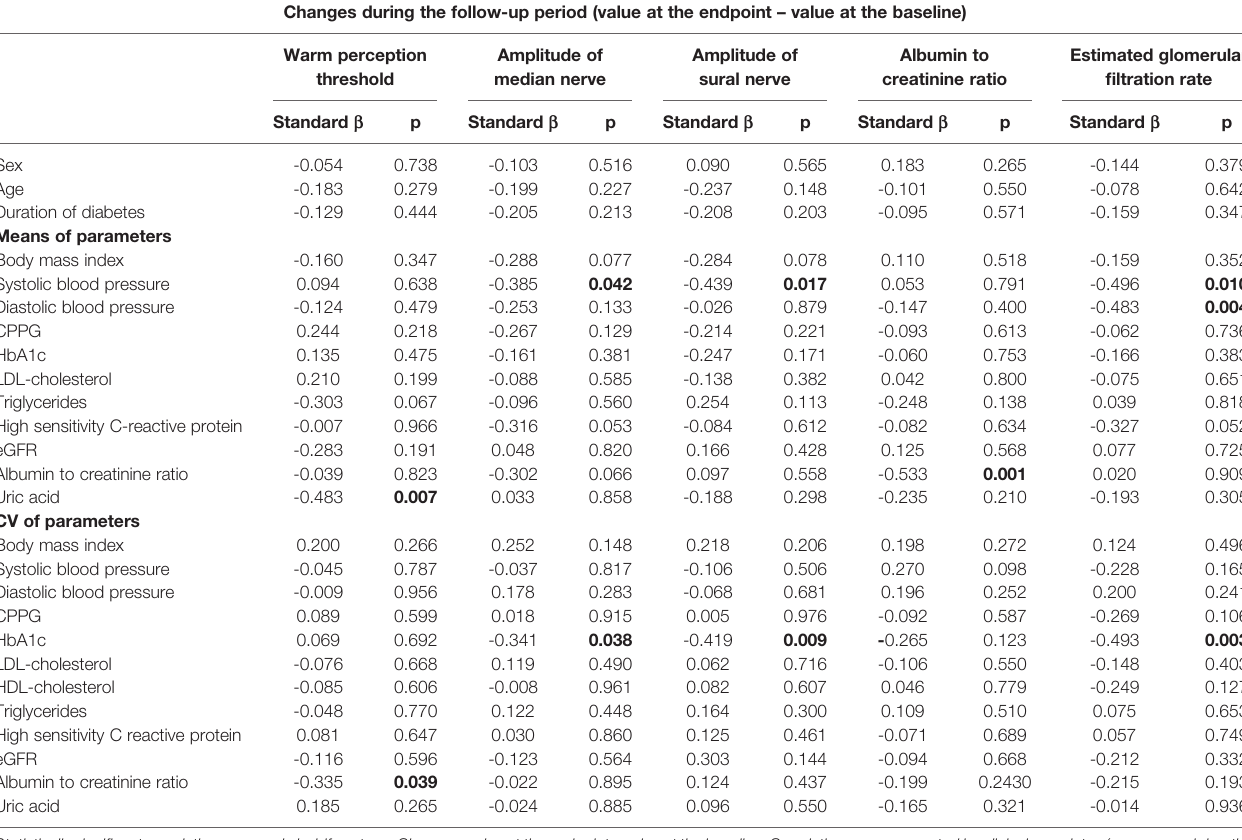
TABLE 3 | Correlations between the changes in warm perception threshold, amplitude of median and sural nerve, albumin to creatinine ratio or estimated glomerular fi ltration rate and mean or coef fi cient of variation of glycemic and extraglycemic factors in patients with type 2 diabetes treated by sodium-glucose cotransporter-2 inhibitors. Changes during the follow-up period (value at the endpoint – value at the baseline)